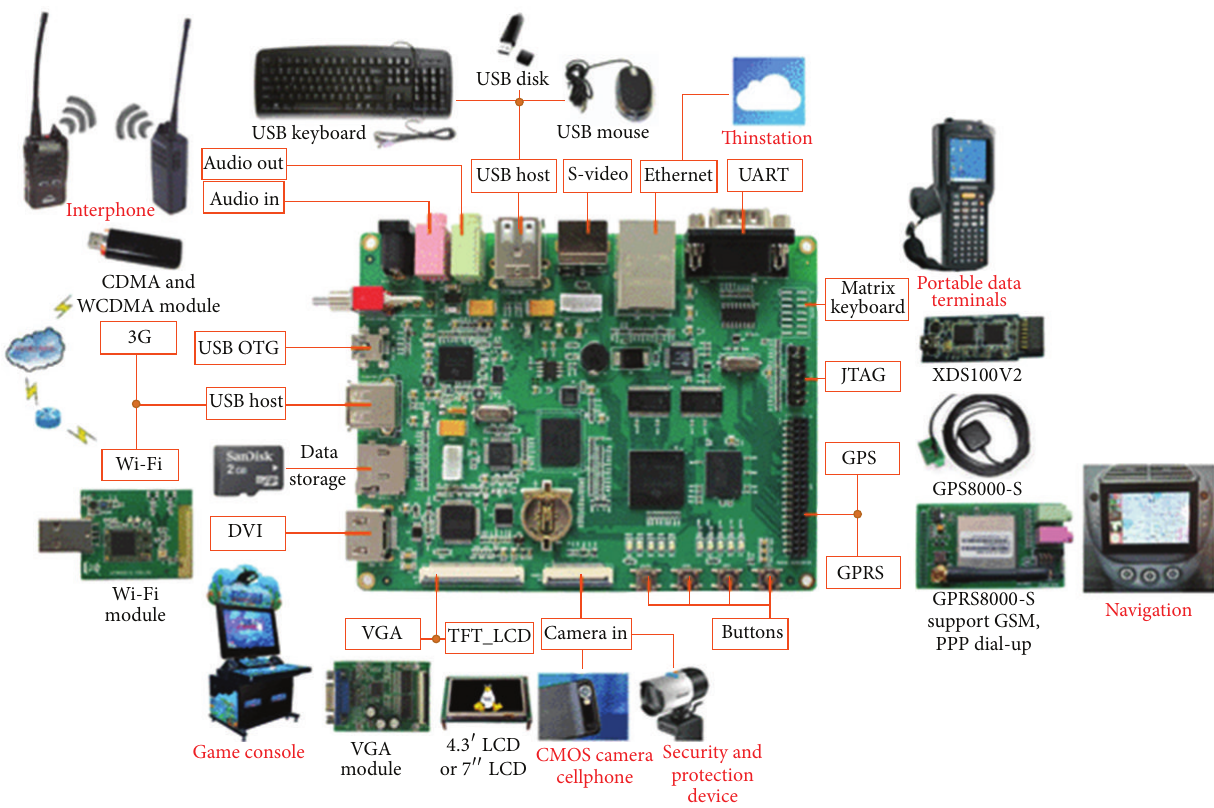
Figure 8: DM3730